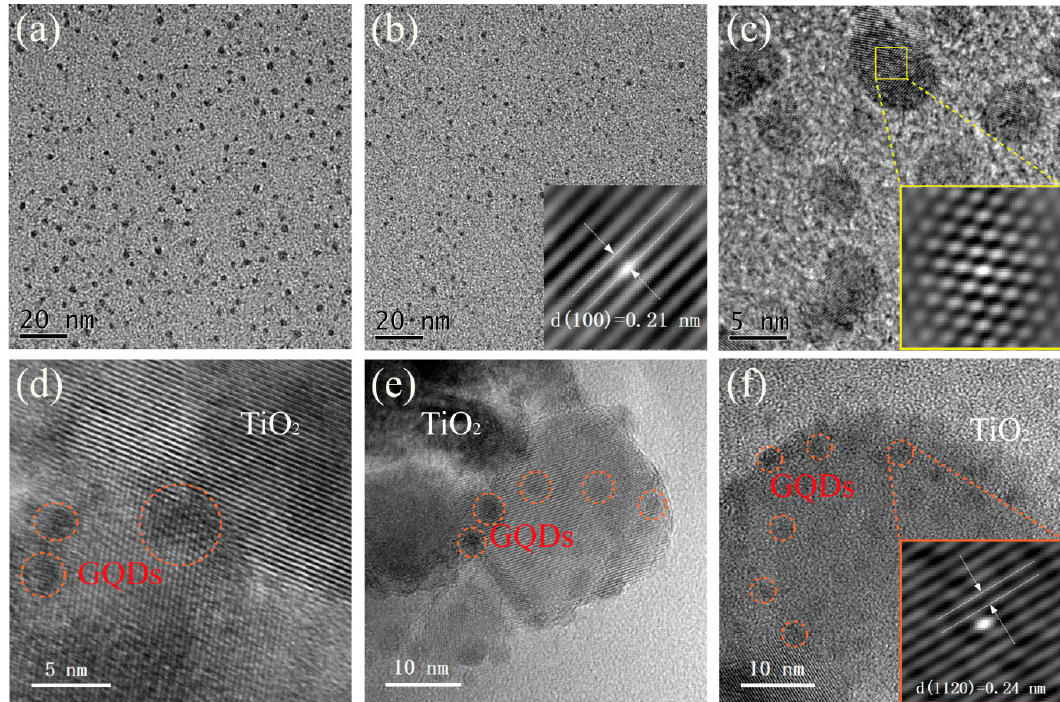
Figure 1. TEM images of ( a ) GQDs, ( b ) y-NGQDs and ( c ) g-NGQDs. The inset in ( b ) is the HRTEM image of y-NGQDs. The inset in ( c ) is the autocorrelated HRTEM lattice images recorded from the corresponding selected areas. The HRTEM images of ( d ) GQDs/TiO 2 , ( e ) y-NGQDs/TiO 2 and ( f ) g-NGQDs/TiO 2 composites. The insert in ( f ) is the autocorrelated HRTEM lattice image of the pristine g-NGQDs/TiO 2 composites recorded from the corresponding selected areas.